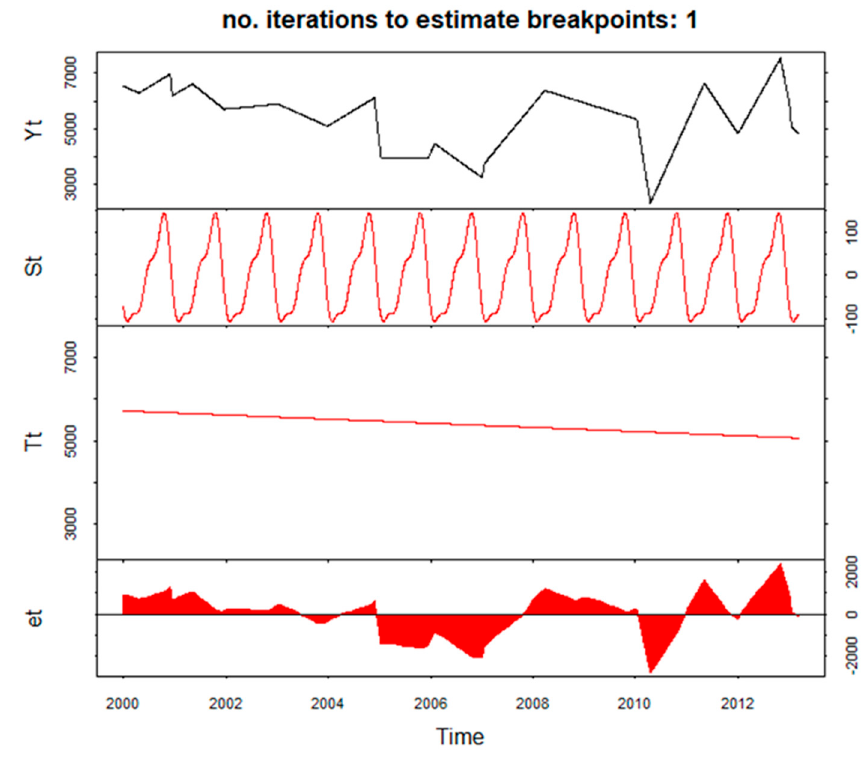
Figure 4. Yearly time (Yt), seasonal trend (St), time trend (Tt), residual component (Et).